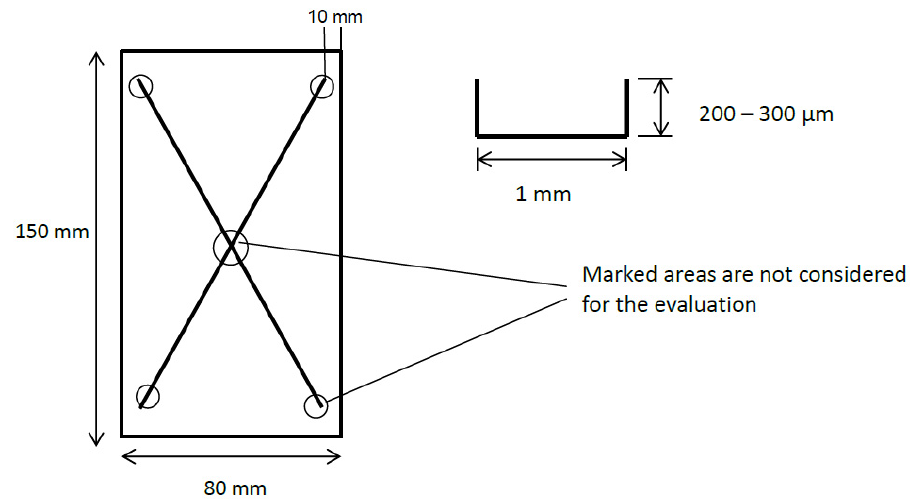
Figure 3. Description of the artificial damage described in ISO 17872 [39] and applied on the painted panels for NSST and FFT.